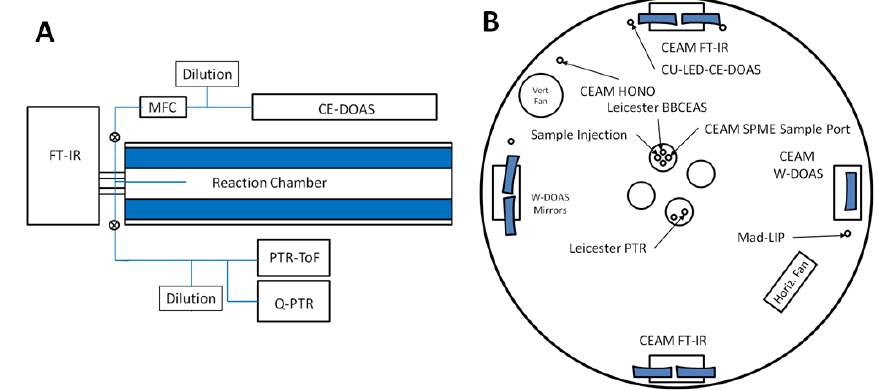
Figure 1. Layout of instruments at NCAR (a) and EUPHORE (b) . In (b) small circles indicate sampling ports; the EUPHORE FTIR, W- DOAS and NCAR-FTIR light paths cross the entire chamber, while other instruments draw air from the chamber for analysis below/outside the